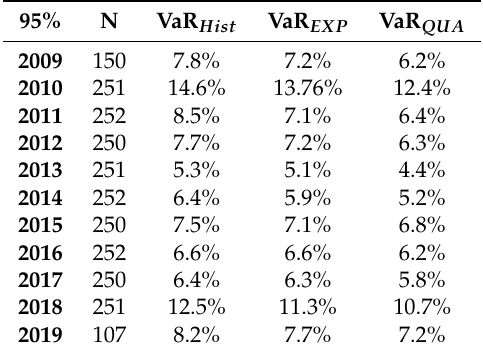
Table 1. Violations